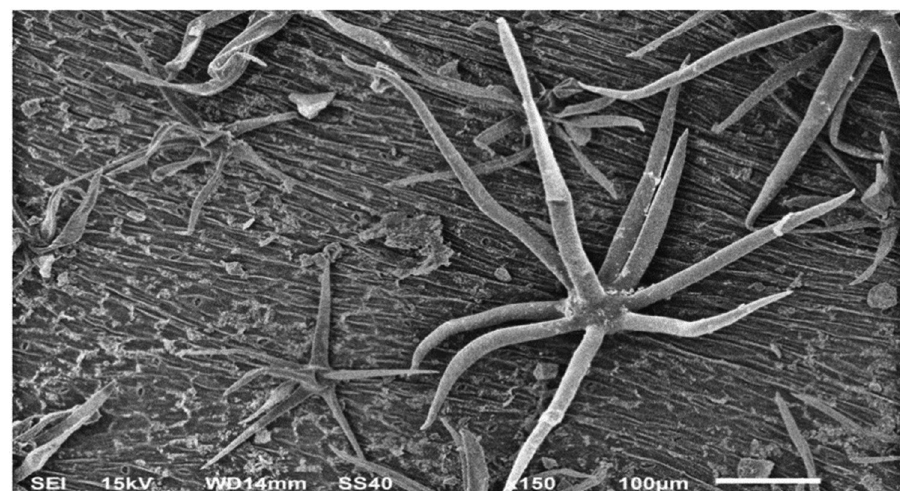
Figure 9: SEM image showing the eggplant leaves sprayed with